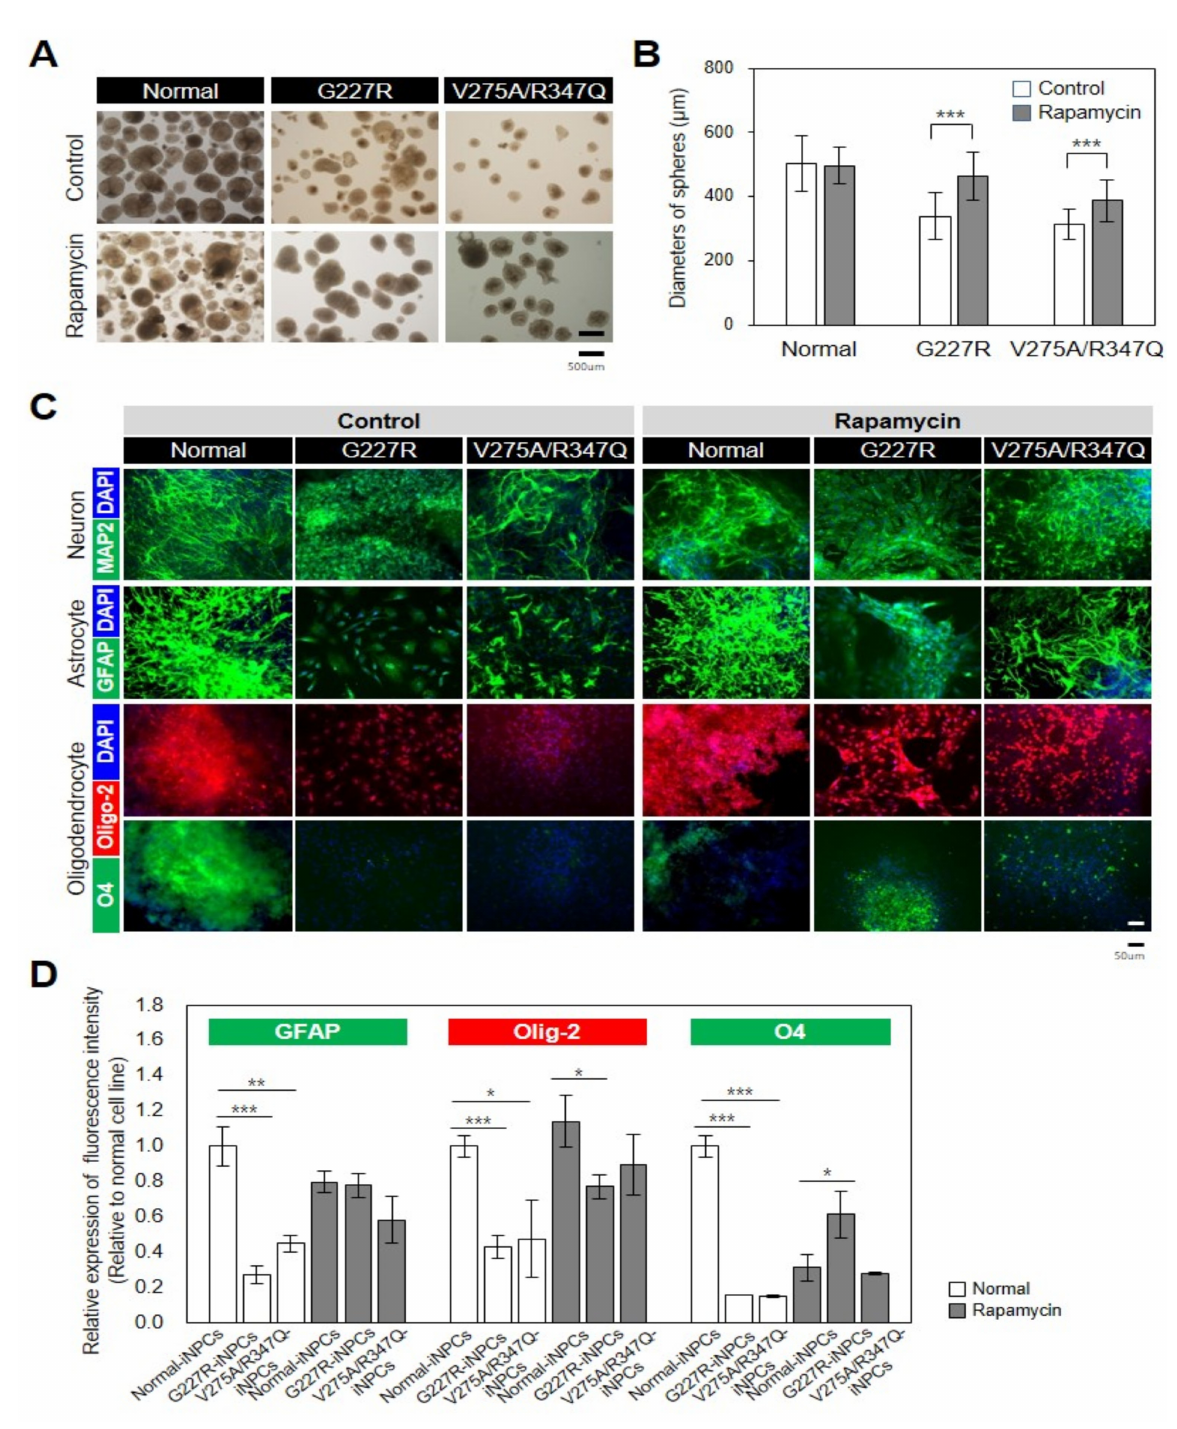
Figure 5. Rescue of disease-associated defects in sialidosis-iNPCs. ( A ) Representative images showing morphological differences between normal- and sialidosis-iNPC spheres (G227R and V275A/R347Q) generated in the absence or presence of 0.1 nM rapamycin treatment. ( B ) Quantification of the average diameters ( µ m) of normal- and sialidosis-iNPC spheres (G227R and V275A/R347Q) shown in A. The data are the means ± SDs of three independent experiments. *** p < 0.001, compared to untreated control ( t -test). ( C ) Representative immunohistochemistry images of normal- and sialidosis-iNPCs (G227R and V275A/R347Q) differentiated into neurons, astrocytes, and oligodendrocytes and stained for the indicated lineage-specific markers. (Scale bar = 50 µ m) ( D ) Quantification of the differentiation potential from Figure 5C images to measure the relative expression of fluorescence intensity. The data are the means ± SDs of at least 3 independent experiments. * p < 0.05, ** p < 0.01, and *** p < 0.001, compared to control normal cell line ( t